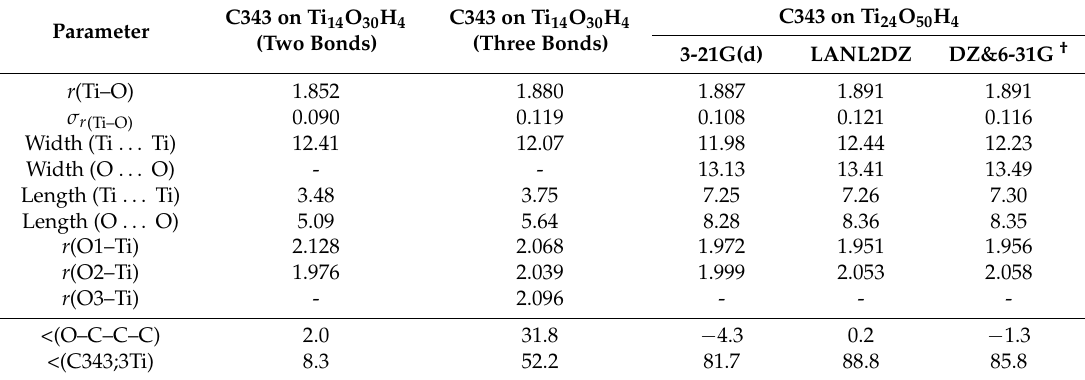
Table 4. The structural parameters of the model system consisting of the Ti n O 2 n +2 H 4 clusters ( n = 14, 24) with an adsorbed C343 molecule, obtained after geometry optimization by DFT with the B3LYP functional, in vacuum. The basis sets used were 3-21G(d) for n = 14 and 3-21G(d), LANL2DZ, and a combination of LANL2DZ on Ti and 6-31G(d,p) on O, C, N, and H atoms (DZ&6-31G) for n = 24. Geometrical parameters describing the adsorption modes: bond lengths (in Å), torsion angle of the carboxyl group relative to the coumarin plane, and dihedral angle defined by the coumarin plane and the plane of the three neighbour Ti atoms (both in deg). C343 on Ti 24 O 50 H C343 on Ti 14 O 30 H 4 C343 on Ti 14 O 30 H 4 Parameter (Two Bonds) (Three Bonds)